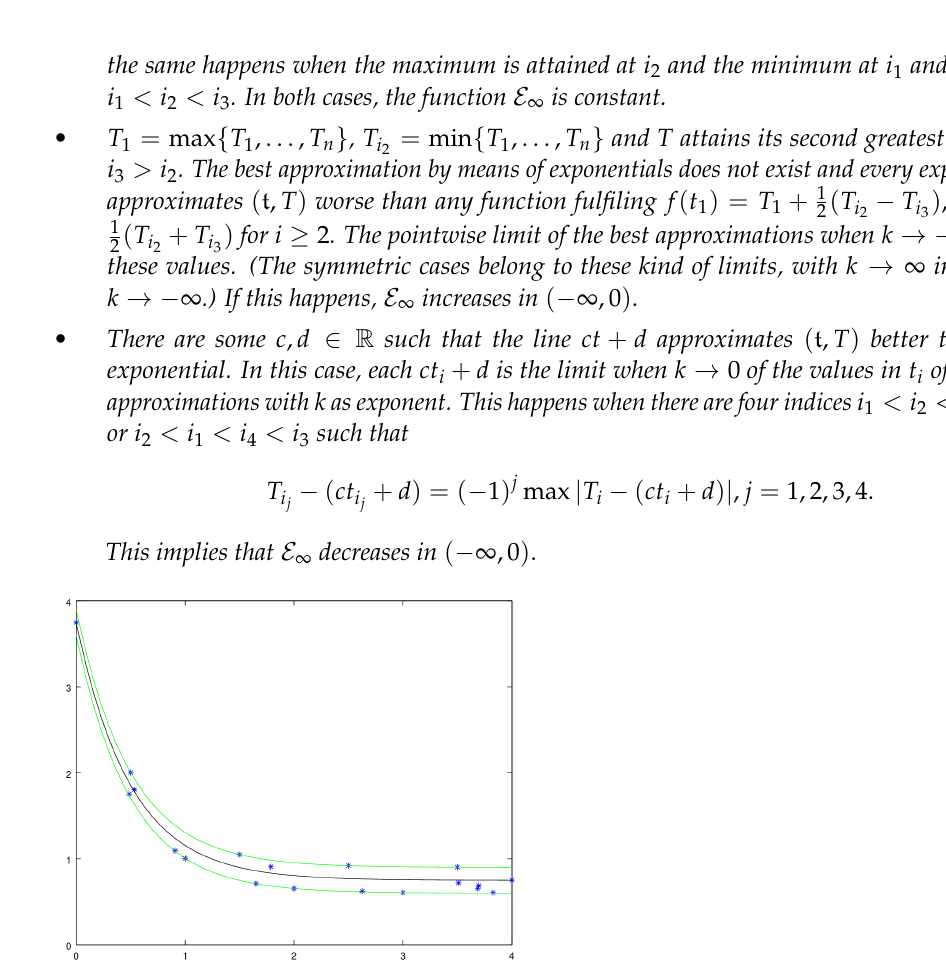
Figure 1. In blue, the points, in black the best approximation and in green the upper and lower borders of the narrowest band that contains ( t , T ) . The band has constant